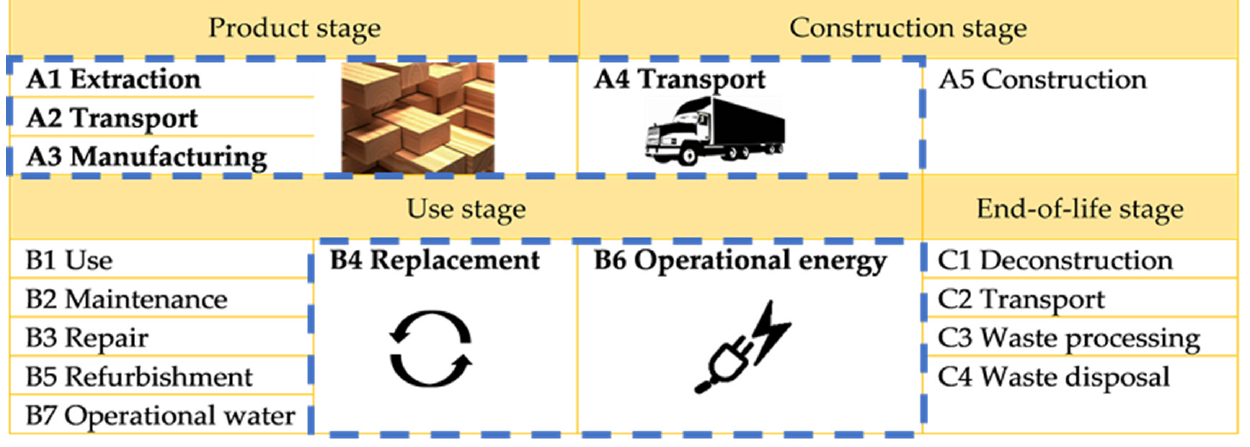
Figure 2. System boundaries.